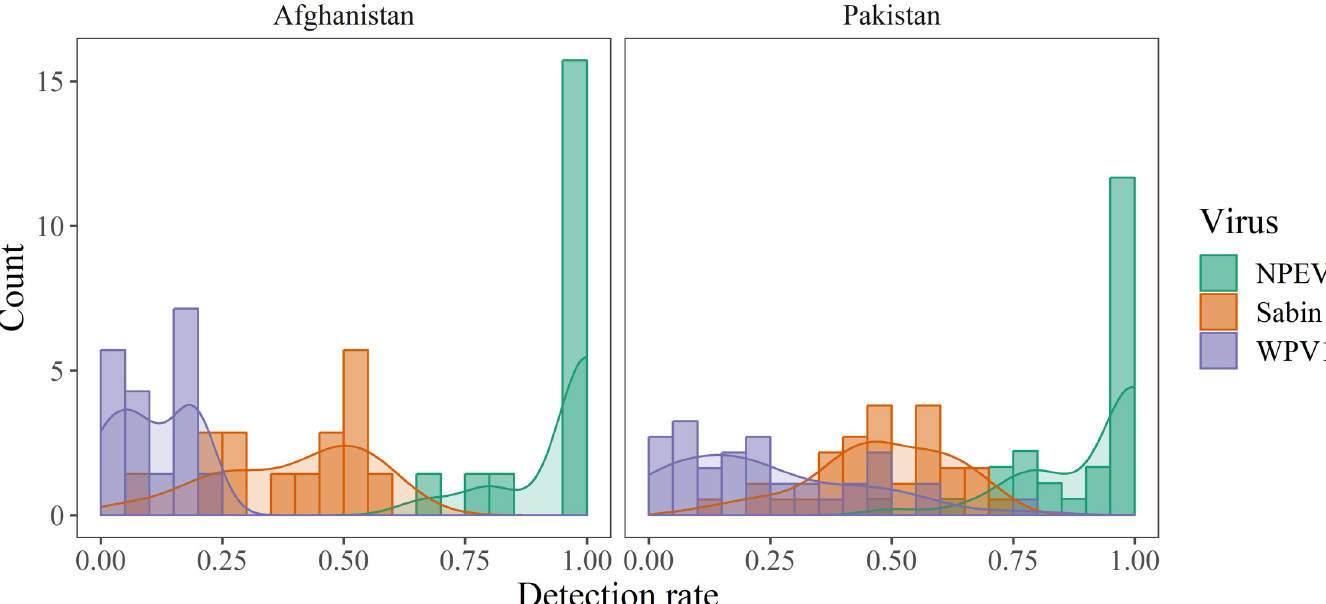
Fig 2. Histograms of ES sites listed by their detection rate of NPEV, Sabin, and WPV1 for Afghanistan and Pakistan. The bars indicate the proportion of positive samples for each virus within each ES site (Sabin averaged across SL1, SL2, and SL3). Detection rates for NPEV are based only on samples without other poliovirus detections to avoid the censoring effects of polioviruses on NPEV reporting. The lines indicate kernel density estimates for the corresponding data.